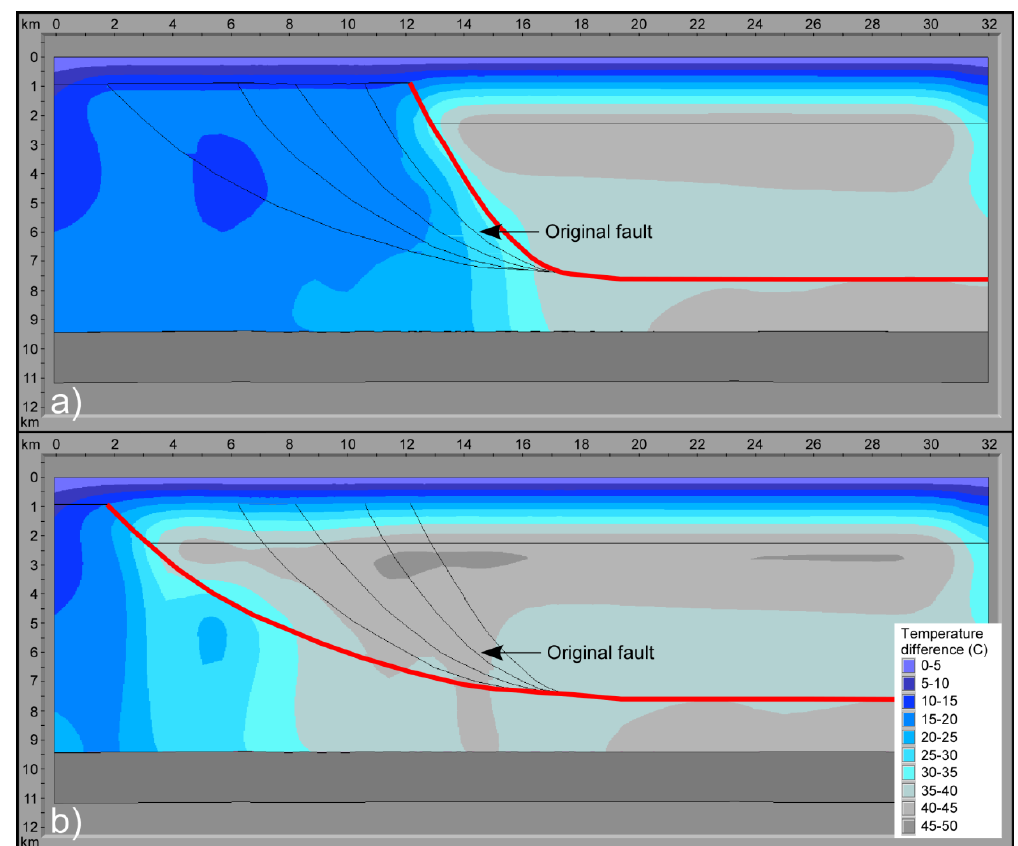
Figure 9. Temperature difference between steady state and transient model 10 kyr after fault slip for the steepest ( a ) and the least steep ( b ) studied listric fault.